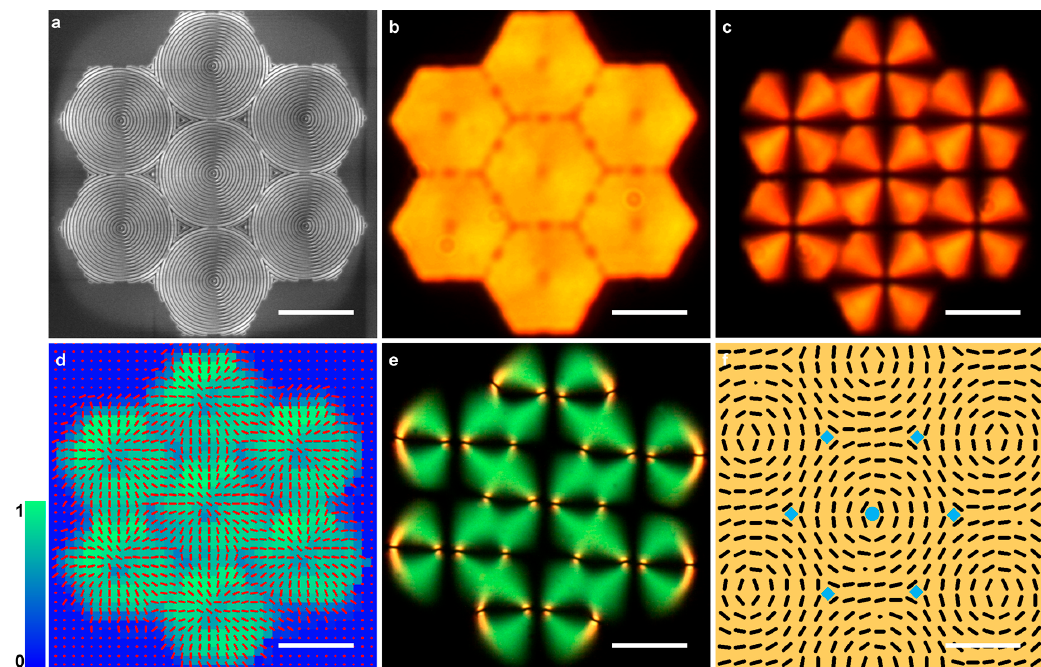
Figure 2. Exemplary PMM with curvilinear nanoslits. ( a ) SEM picture of a PMM; ( b ) Bright-field optical microscopy image of the PMM; ( c ) Cross-polarized optical microscopy image of the PMM; ( d ) Measured polarization direction for light transmitted through the PMM, the scale bar on the left hand side indicates the optical transmission; ( e ) Cross-polarized microscopy texture of a nematic LC in a cell patterned with the PMM; ( f ) Director pattern of the nematic LC cell shown in ( e ), the blue circle and diamonds correspond to the center of +1 and − 1/2 topological defects, respectively. The scale bars are 5 μ m in ( a – d ) and 25 μ m in ( e , f ).